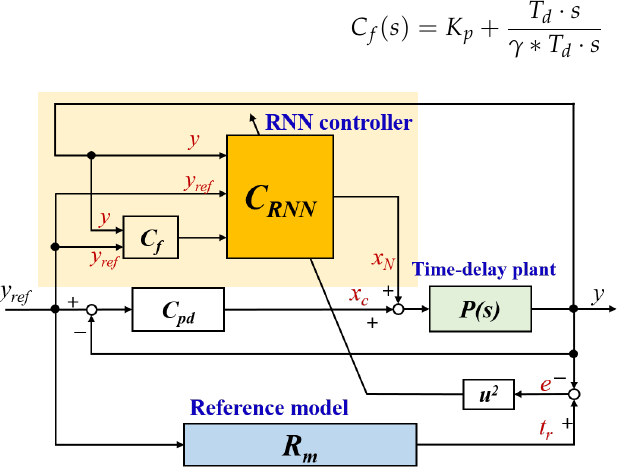
Figure 1. Proposed RNN-model based temperature control